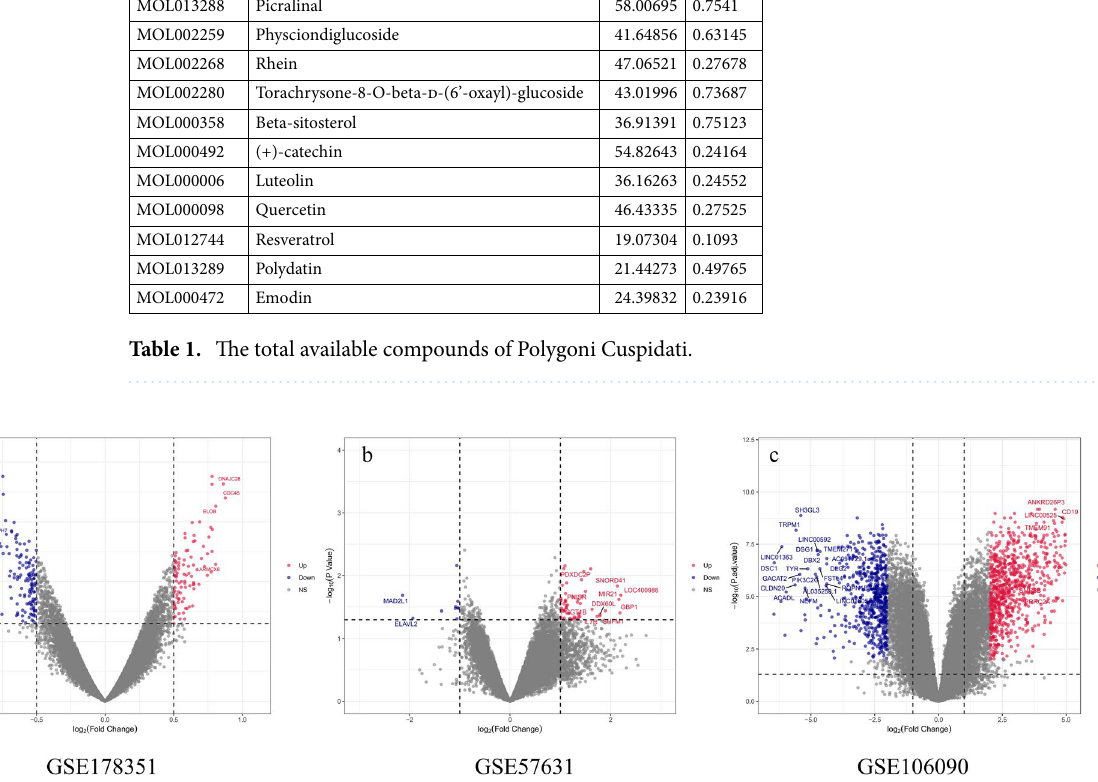
Figure 1. Volcano plot of the distribution of low expression of genes in patients with CP. DEGs ( a GSE178351, b GSE57631, c GSE106090), Red represents high expression of genes in patients with Peri-implants, while blue represents lower expression of genes (R 3.6.3 https:// cran.r- proje ct. org/ bin/ windo ws/ base/ old/3. 6.3/).